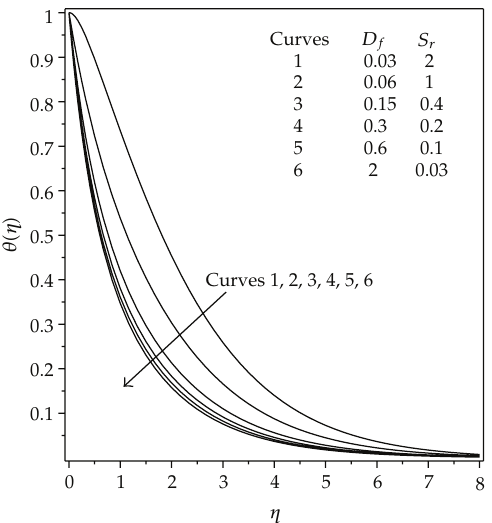
Figure 9: Concentration profiles for di ff erent values of D f and S r when Pr (cid:9) 0 . 78, Sc (cid:9) 0 . 6, r (cid:9) 1, M (cid:9) 1, and f 0 (cid:9)